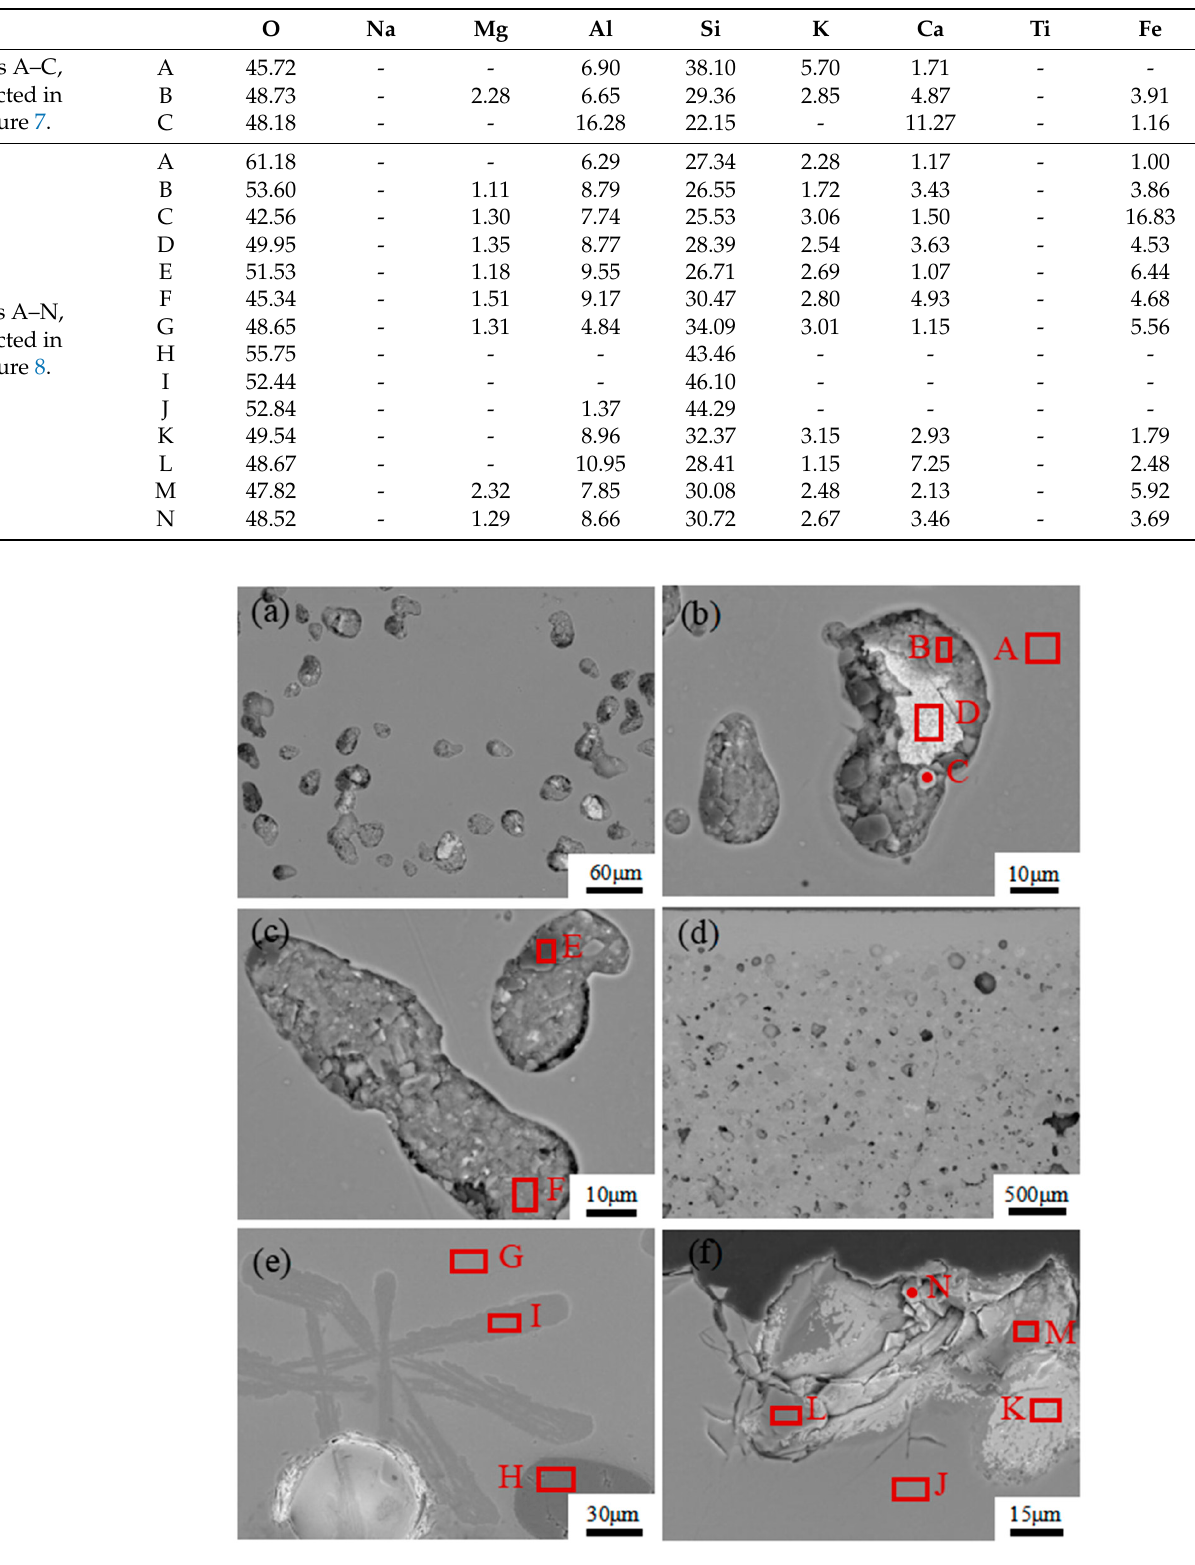
Figure 6. SEM images of tea-dust-glazed porcelain (JZ-07) with different magnification: ( a – c ) surface morphology; and ( d – f ) the polished cross-section morphology.